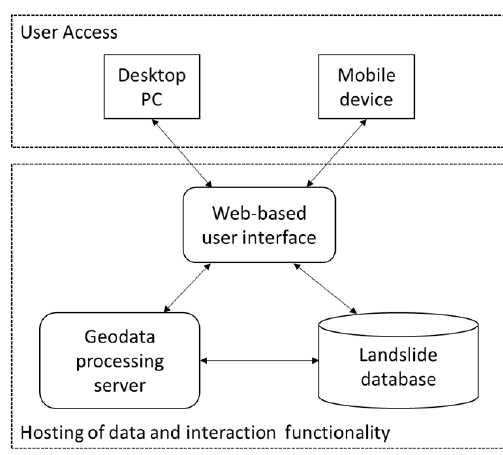
Figure 1. Conceptual structure for